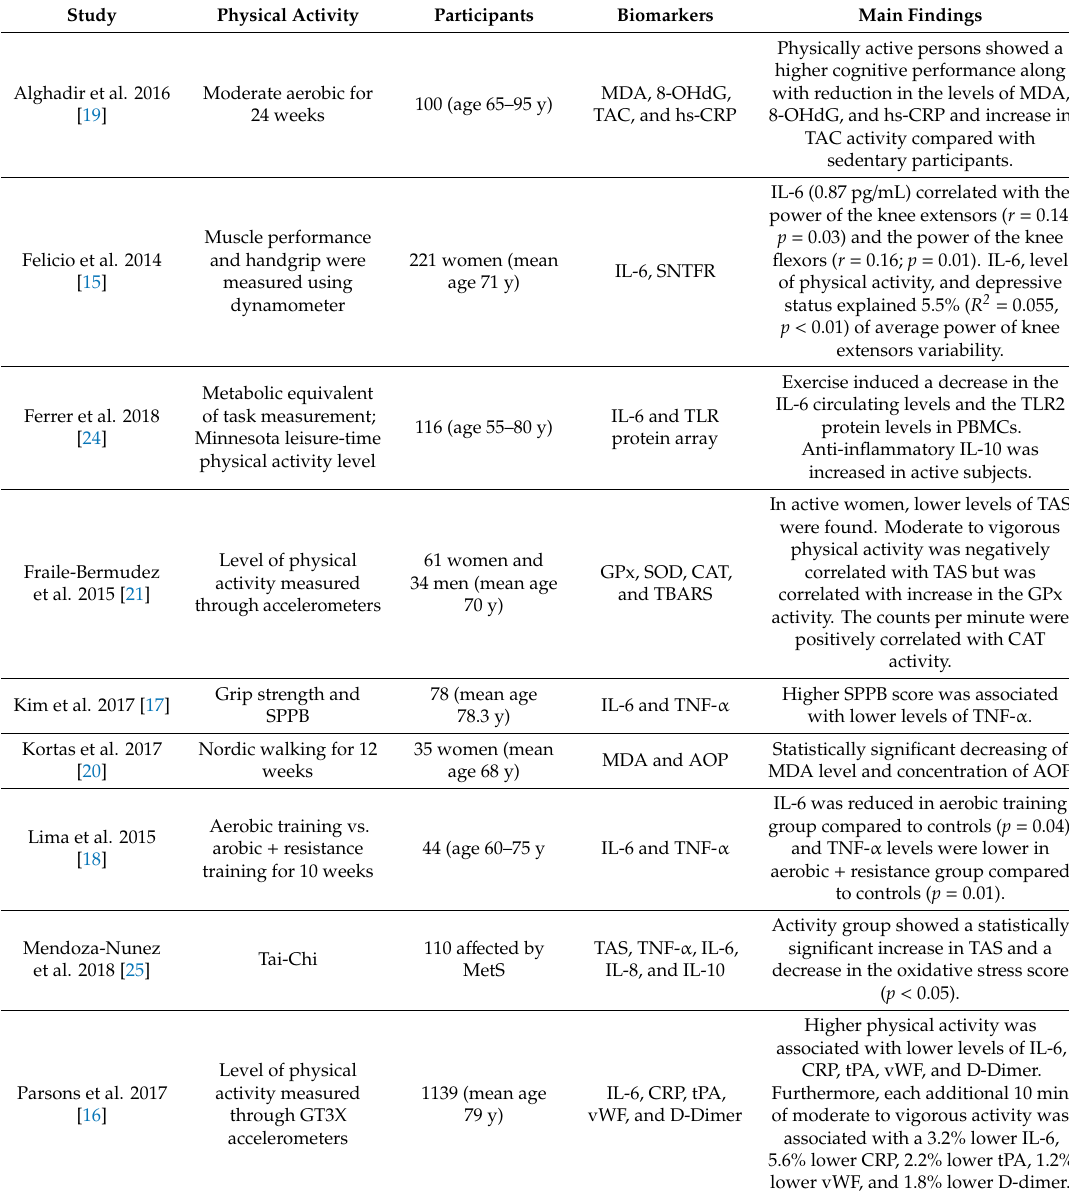
Table 1. Inflammatory markers and oxidative stress